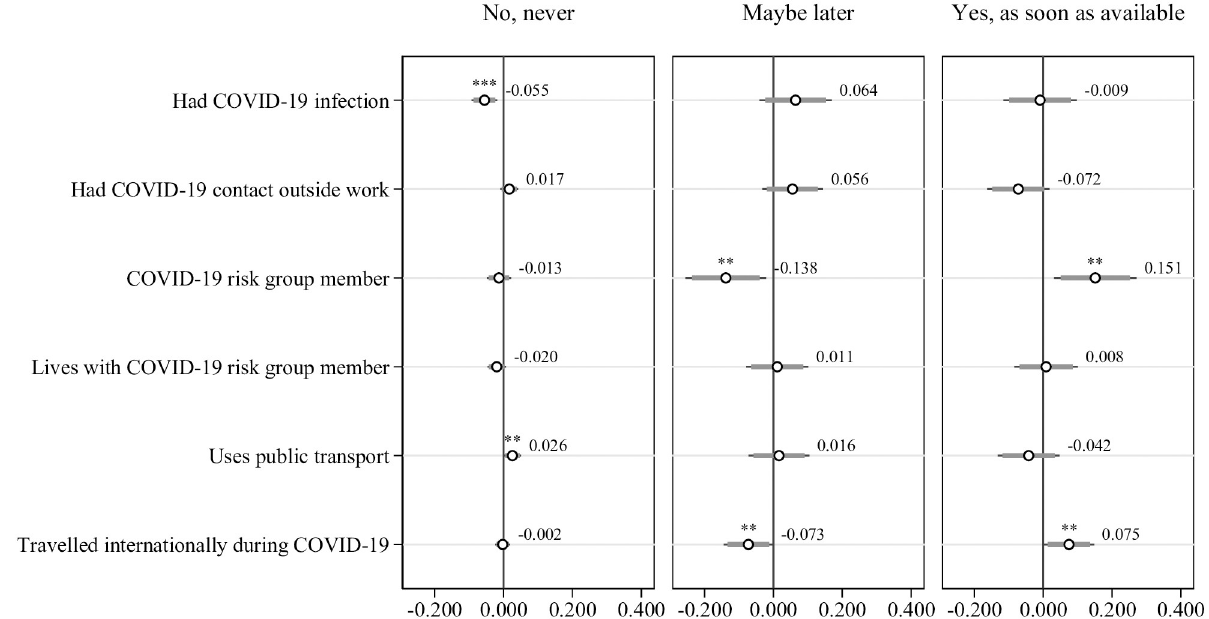
Fig 5. Multinomial probit regressions: Willingness to get vaccinated and situational factors, controlling for individual characteristics, Big-5 personality traits and preferences Dependent variable is willingness to get vaccinated. Individual characteristics include being female, being younger, education, being a healthcare worker, and being native. Preferences include the level of trust in strangers, risk aversion, patience, future orientation, altruism and reciprocity. Personality traits include extroversion, agreeableness, conscientiousness, stability and openness. All regressions include hospital and time fixed effects. Standard errors in parentheses, n = 915. � p < 0.1, �� p < 0.05, ��� p < 0.01, ���� p <